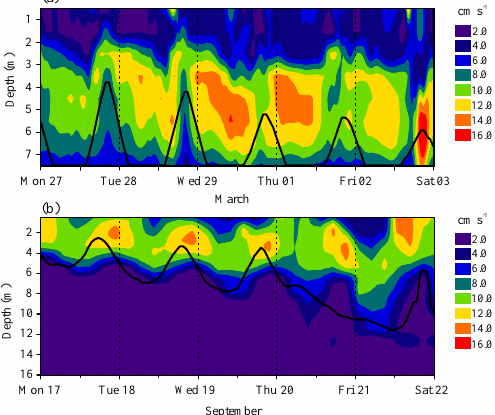
Figure 6. Simulated velocity profile using realistic forcing. Higher velocities represent the depth where the river flows though the tran- sition zone. The river flows as underflow during the rainy season when a denser (colder) river plunges beneath the surface and flows downward along the bottom as a gravity-driven density current (a) . The river flows as overflow during the dry season, when the tem- perature from the river and reservoir are similar (b) . As overflow, the river characteristics can be found many kilometers toward the dam at the water surface. The black line represents the depth of neutral buoyancy as estimated from temperature records, presum- ing that the lake and river water do not mix. The anomaly observed in the river flow and depth of neutral buoyancy between 20 and 21 September 2012 occurred due to a decrease in the river tempera- ture during a rainfall that occurred at approximately 16:00LT on 20 September.